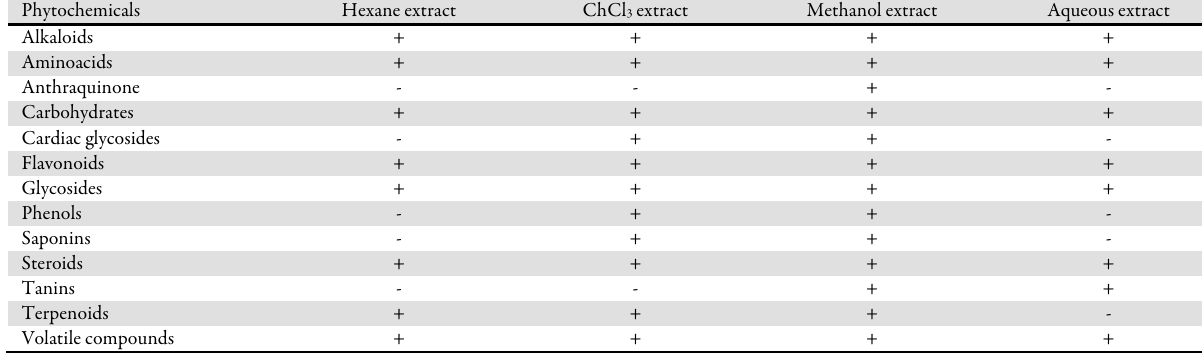
Table 3. Phytochemical constituents of Bridelia retusa fruits